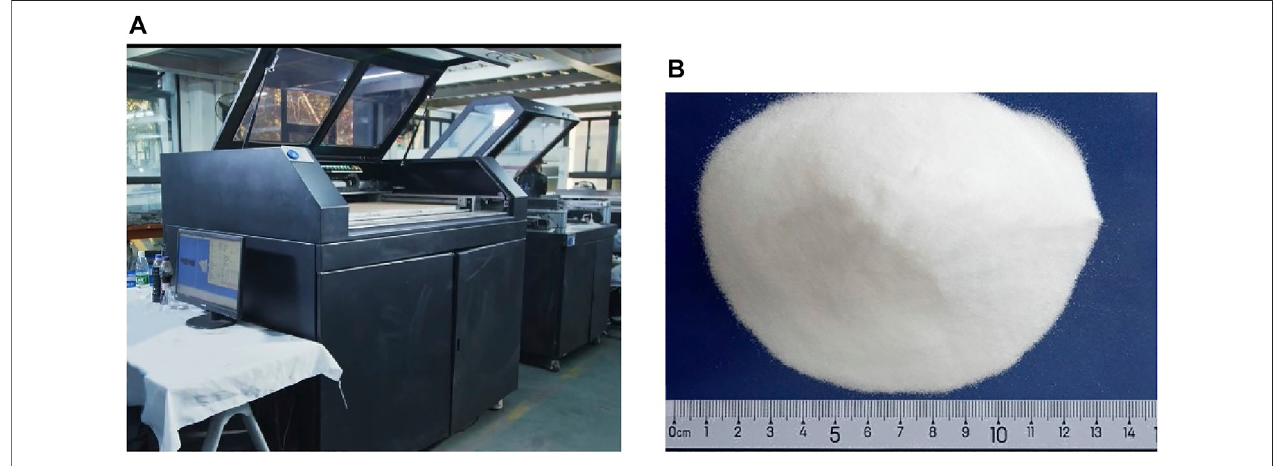
FIGURE 1 | (A) Easy3DP-S500 printer. (B) Quartz sand